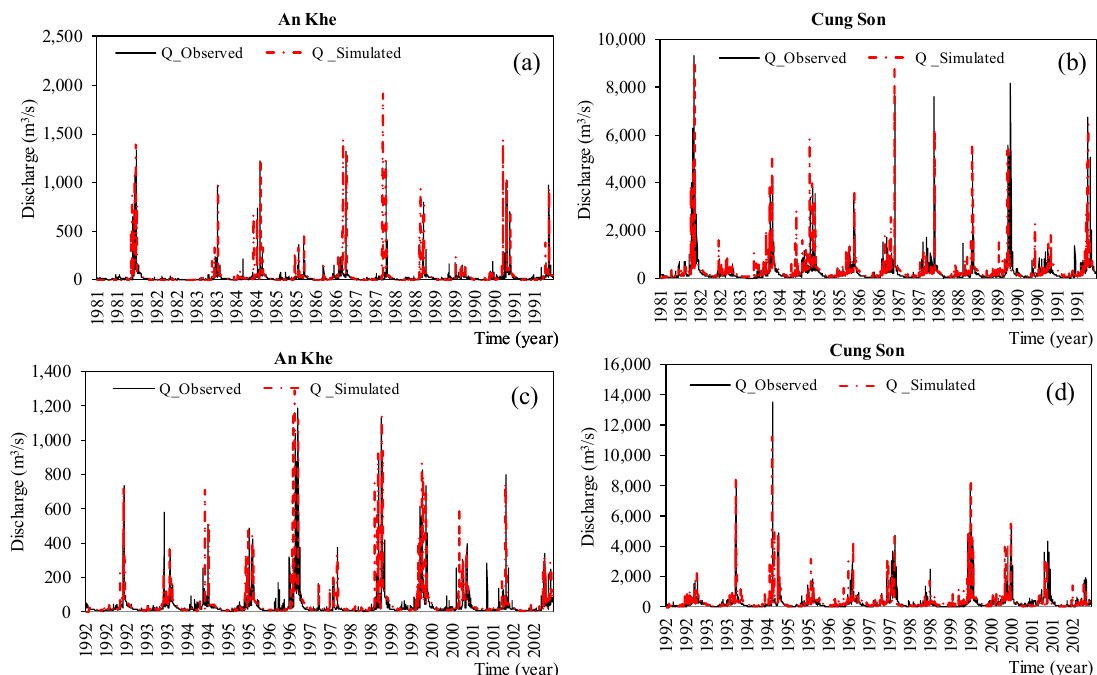
Figure 6. Calibration and validation of the water discharge at two stations, An Khe and Cung Son, from the periods 1981–1991 ( a , b ) and 1992–2002 ( c , d ).